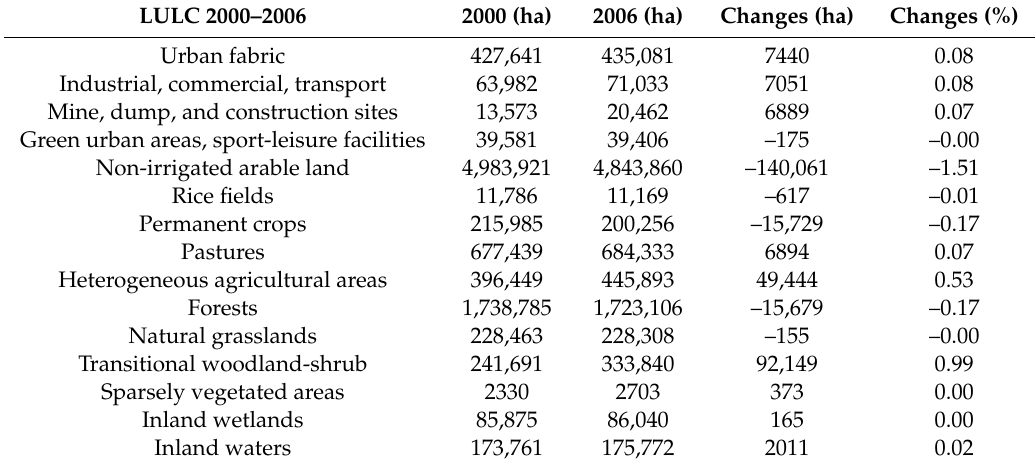
Table A2. Area a ff ected by LULC change in Hungary between 2000 and 2006.